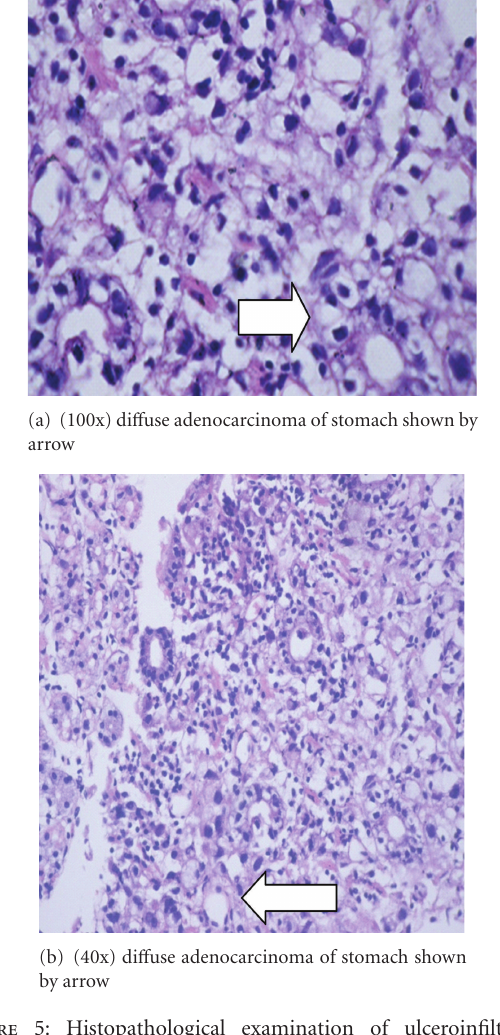
Figure 5: Histopathological examination of ulceroinfiltrative growth of stomach showing malignant signet ring cell and signif- icant dysplasia and altered gland